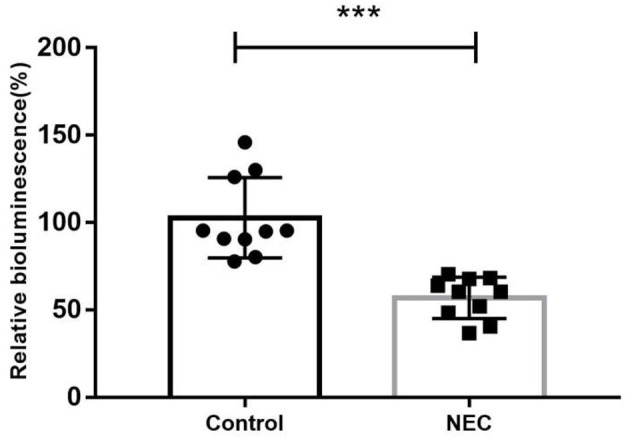
The relative biofluorescence values of AI-2 in feces from two groups of newborn mice (***P < 0.0001).